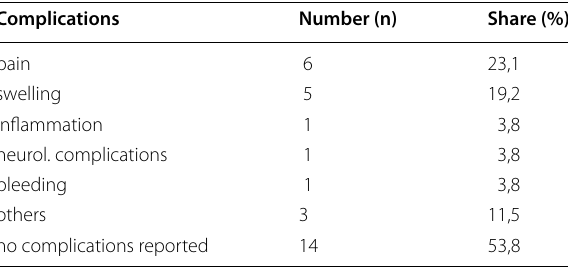
Table 10 Share of certain complications after treatment